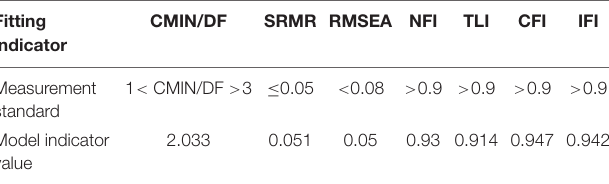
TABLE 6 | Adaptation analysis of villagers’ participation in micro-landscape construction model.